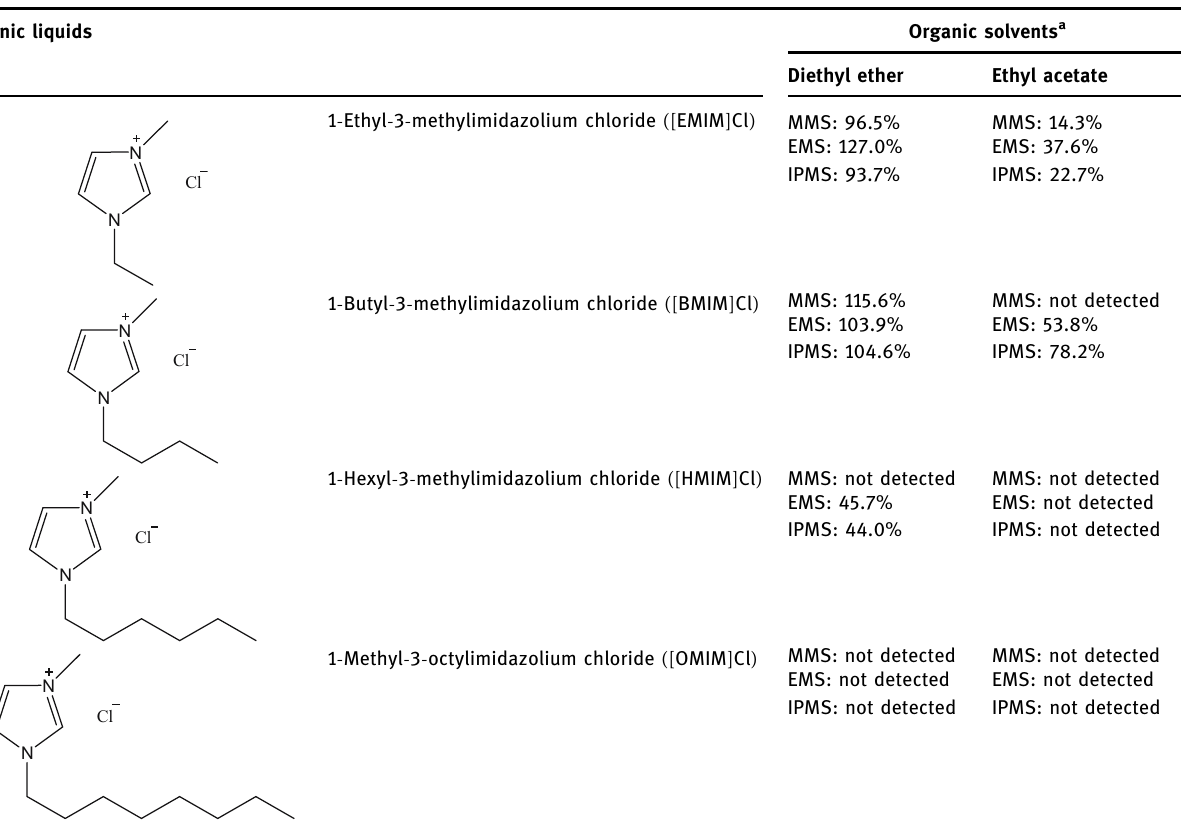
Table 1: Summary for the screening ionic liquids and organic solvents focused on the carbon chain length of ionic liquids Recovery ( % ) of spiked MMS, EMS, and IPMS at 0.5µg/mL into the sample solution ( equivalent to 1 ppm in the delgocitinib drug substance ) Ionic